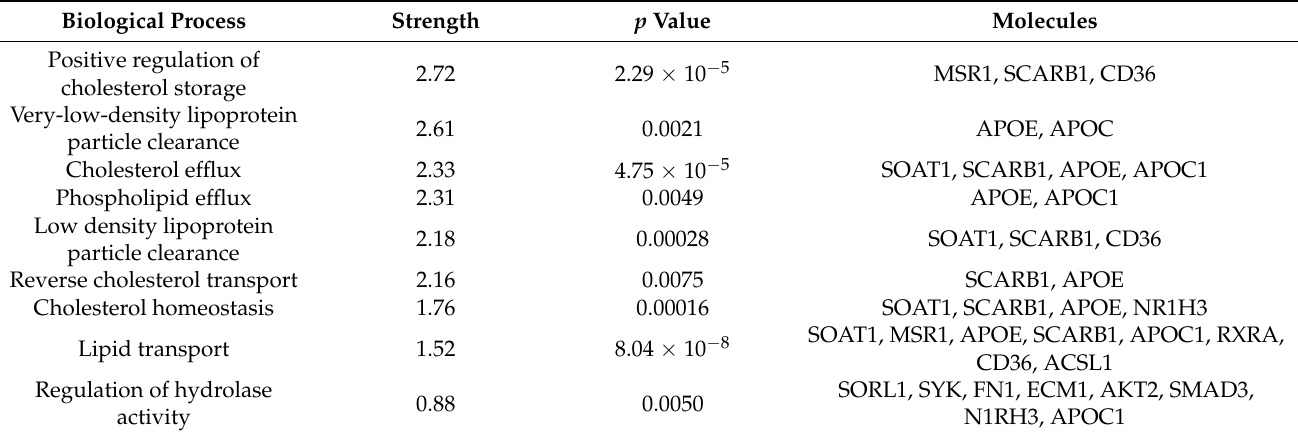
Table 4. Biological processes derived from functional enrichment networks associated with genes affected by IFN- γ + kaempferol treatement.